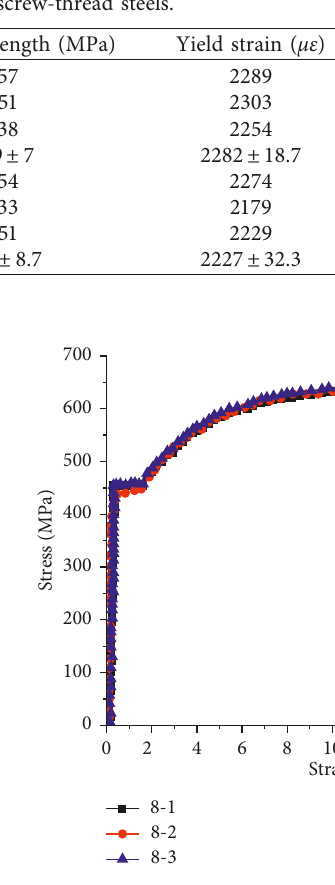
Figure 6: Stress-strain curves of 6mm screw-thread steels. Figure